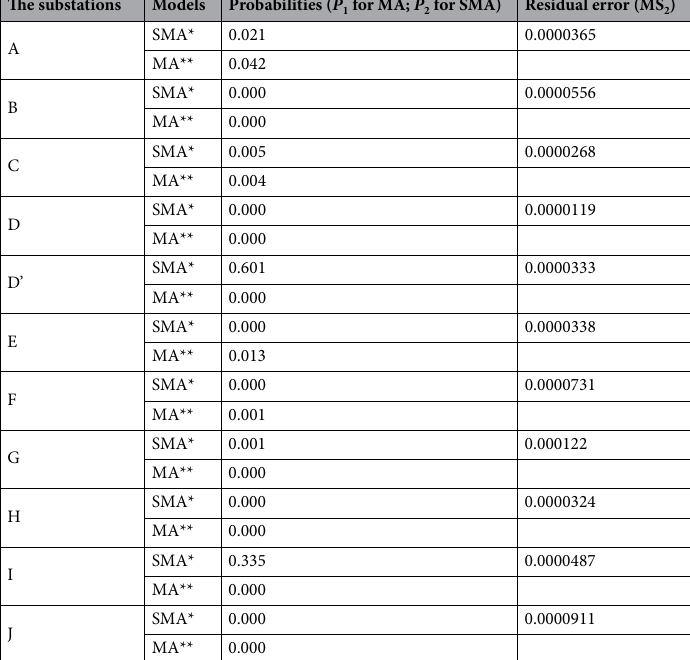
Table 2. The analysis of SARIMA ( 0,1,1 ) × ( 0,1,1 ) model for the closed process in different substations. *SMA model implies the SARIMA ( 0,1,1 ) × ( 0,1,1 ) model. **MA model implies the ARIMA ( 0,1,1 ) model.